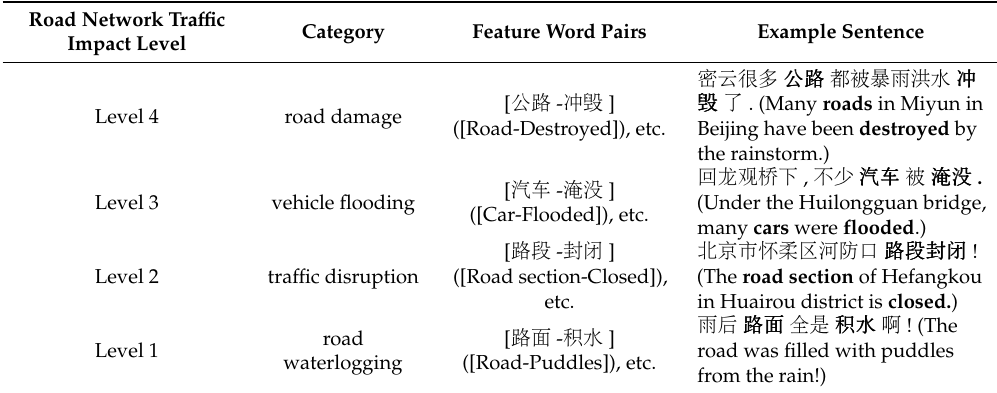
Table 1. Classification of road conditions.